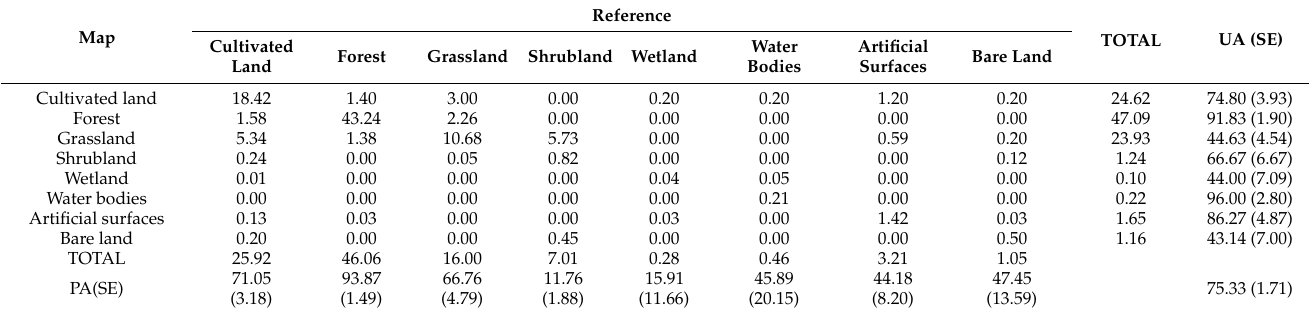
Table A3. Error matrix of GLC_FCS30 2010.